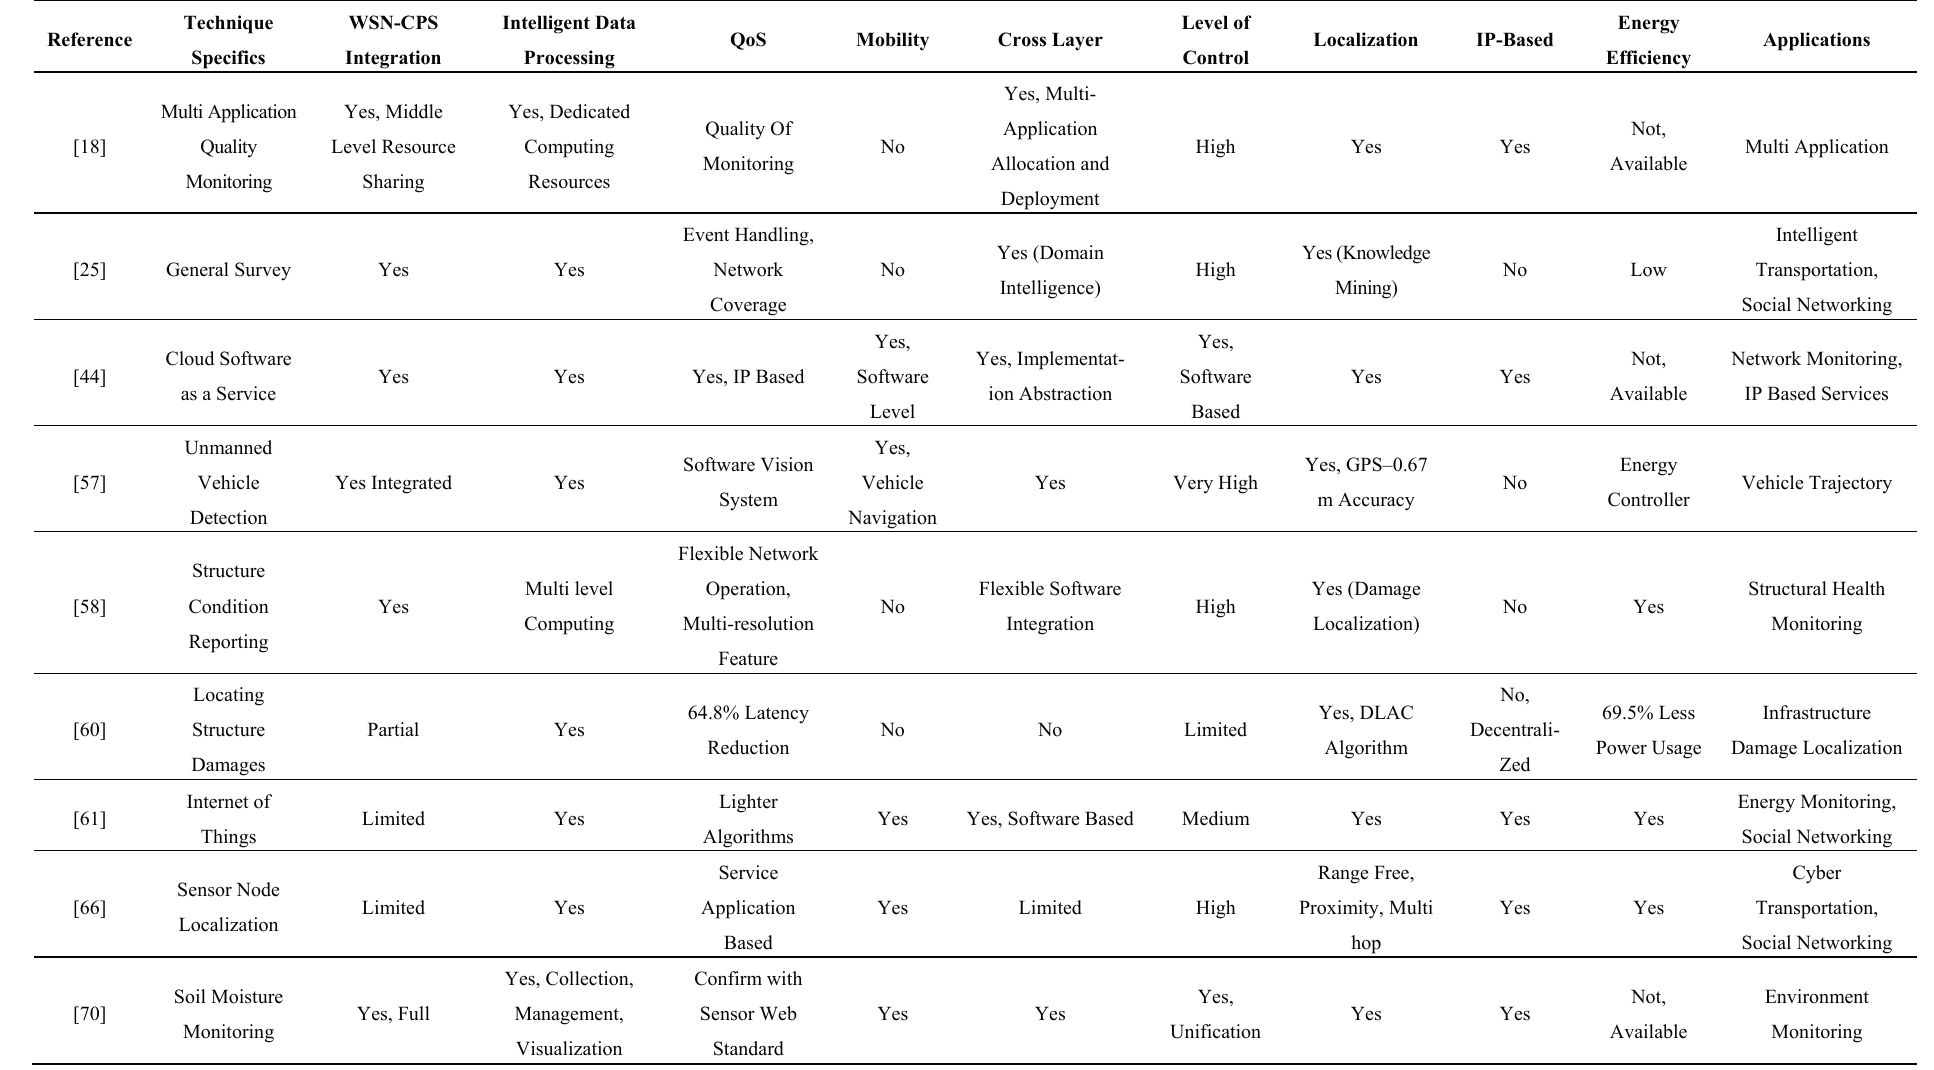
Table 7. Summary of CPSN architectures for infrastructure